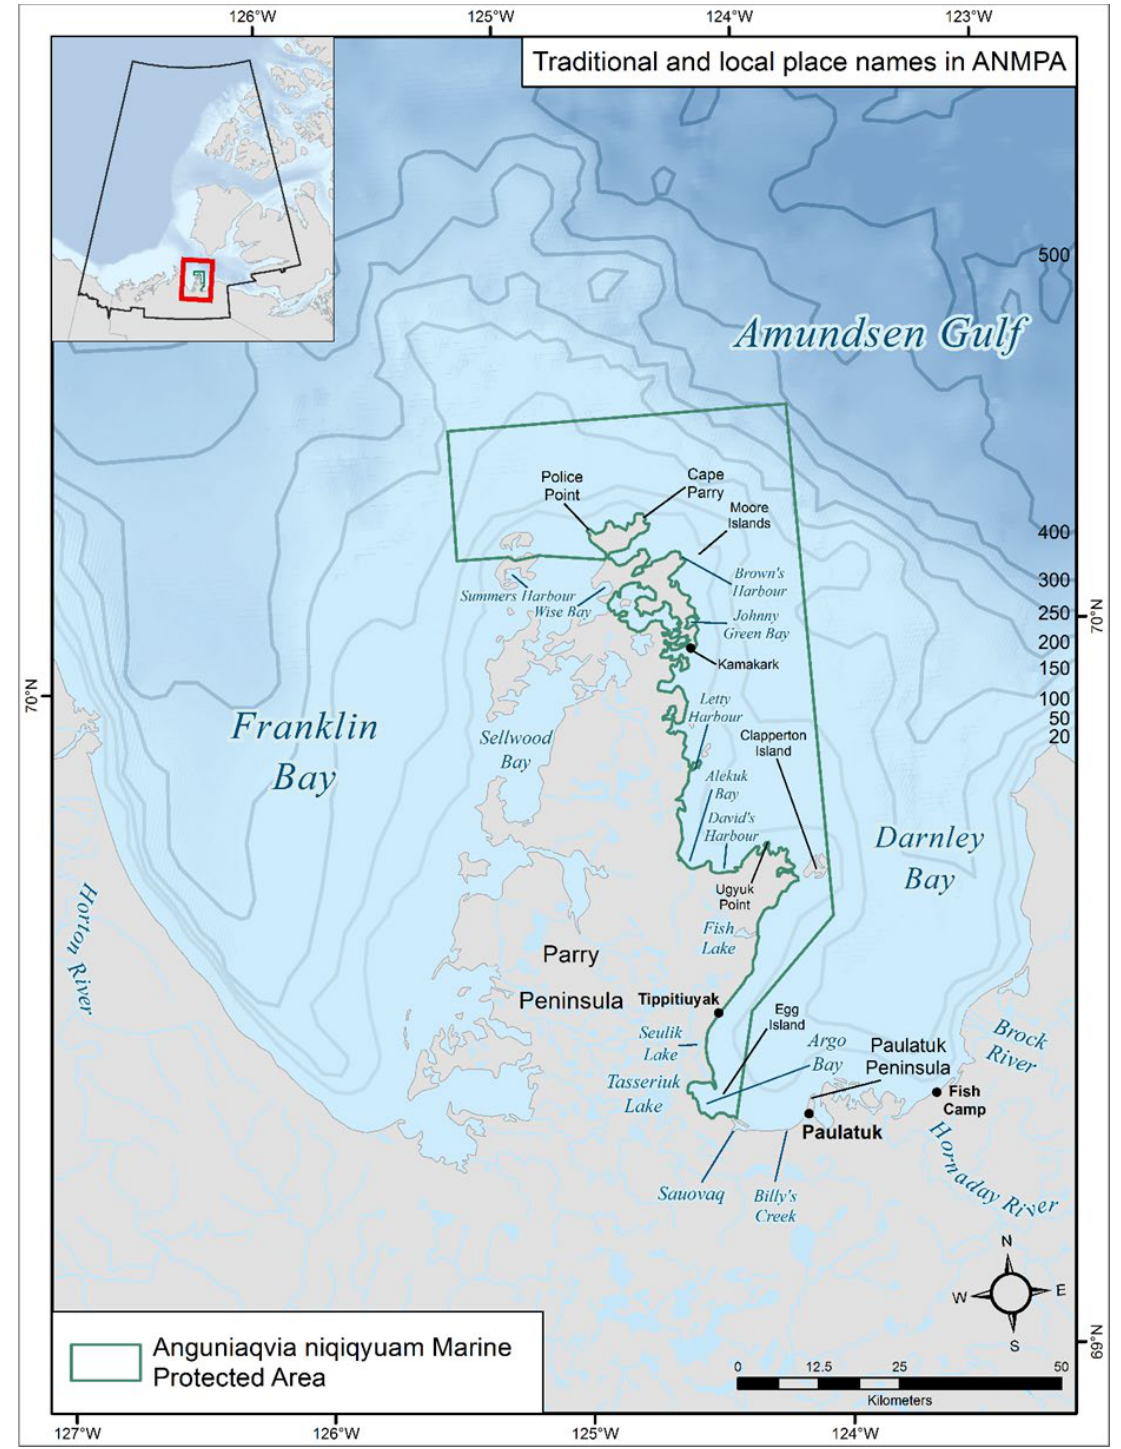
Figure 1. Map of traditional and local place names in the Anguniaqvia niqiqyuam Marine Protected Area. Map created by J. Friesen and local place names provided by the ANMPA Working Group. Bathymetry adapted from the IBCAO by M. Ouellette. Base map obtained from Open Government